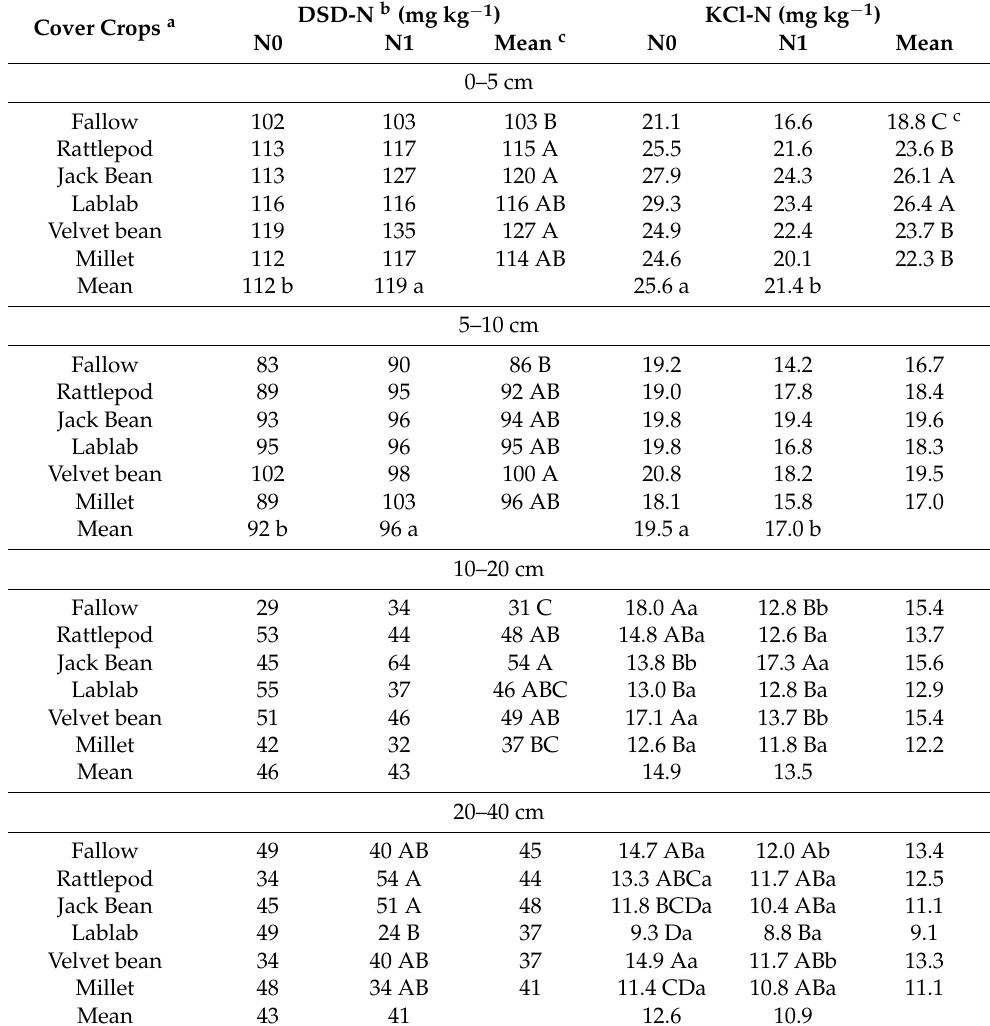
Table 7. Soil potentially available nitrogen measured by direct steam distillation and hot KCl methods in soil samples collected from 0–5, 5–10, 10–20, and 20–40 cm layers as a function of cover crops grown before maize and nitrogen fertilizer